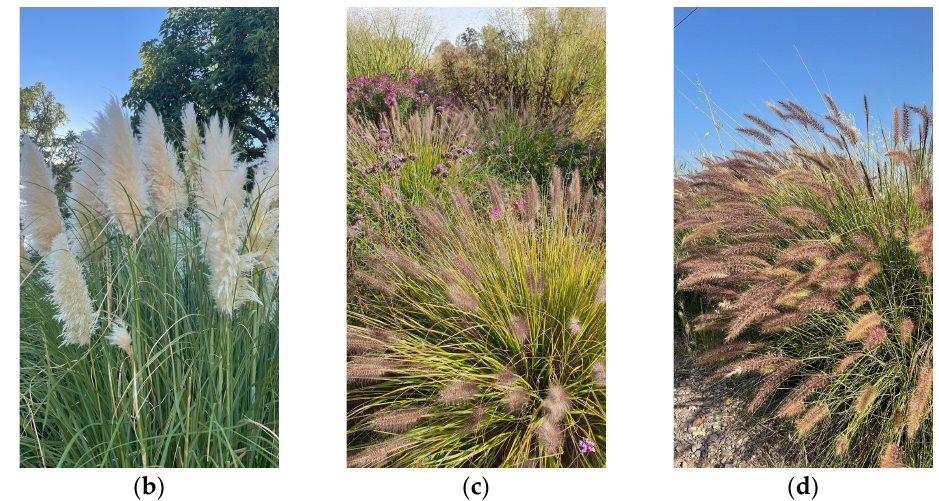
Figure 1. The species analysed in the study: ( a ) Cymbopogon citratus , ( b ) Cortaderia selloana , ( c ) Pennisetum alopecuroides , and ( d ) Pennisetum setaceum .